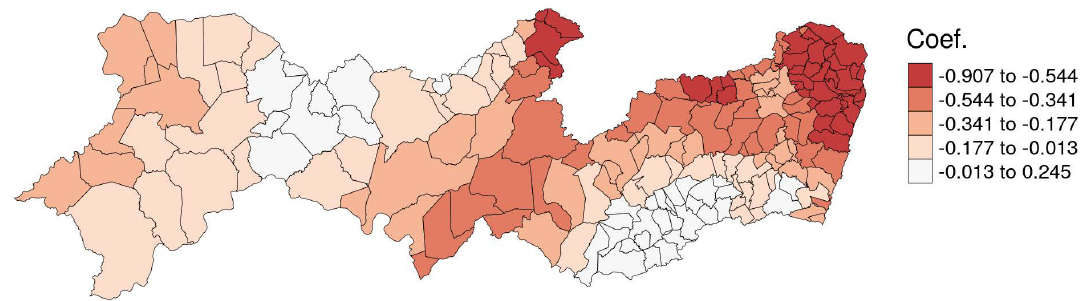
Figure 7. Distribution of the local coe ffi cients of the GWR model (HDI).